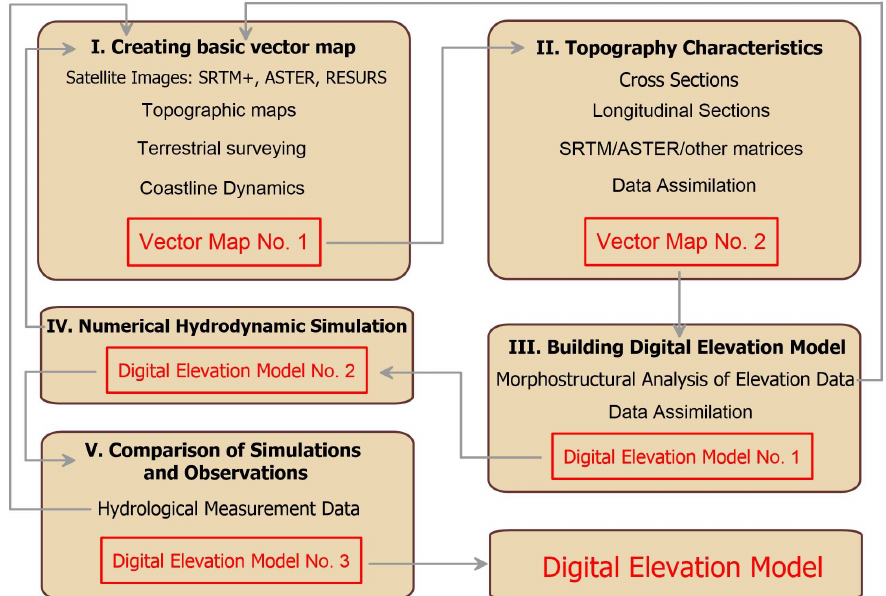
Figure 3. Diagram of creating and updating a digital elevation model